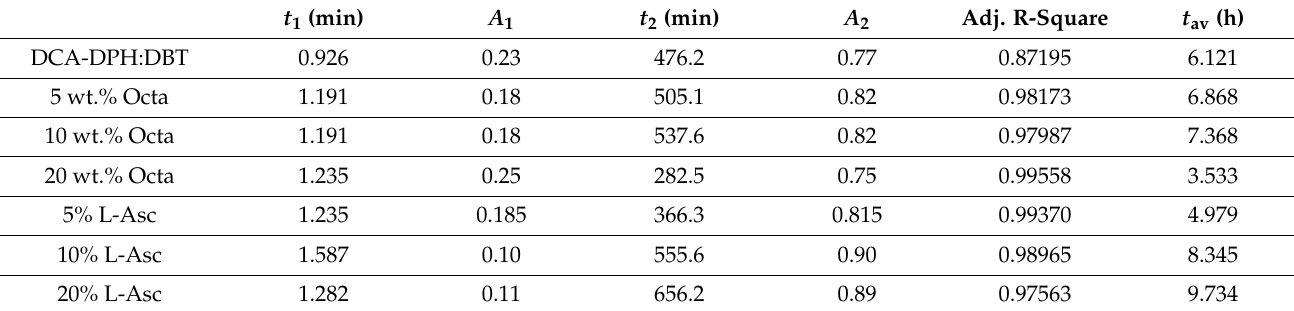
Table 1. Parameters of bi-exponential fits of the photodegradation aging tests and correspond- ing decay times for DCA-DPH:DBT samples with and without 5 wt.%, 10 wt.% and 20 wt.%